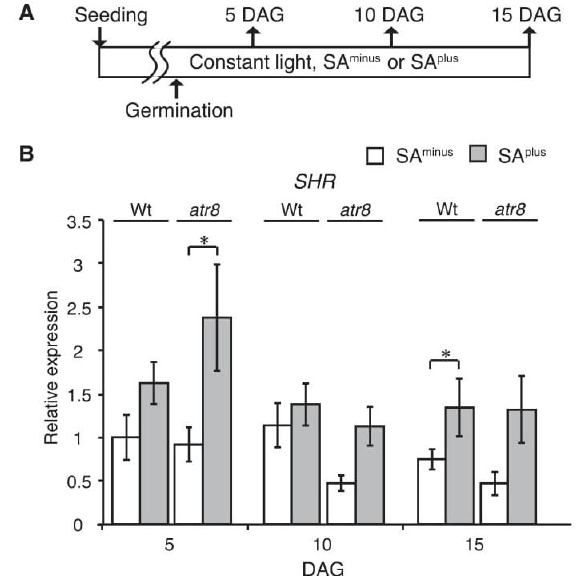
Figure 3. Accumulation levels of SHR mRNAs in Wt and atr8 plants soon after germination. ( A ) Timeline of experimental procedure. Up arrows indicate samplings. ( B ) Time course of SHR mRNA accumulations. Arabidopsis seedlings that were grown on vertical 0.24% gellan gum media with (SA plus ) or without (SA minus ) 20 µM salicylic acid, and total RNAs were extracted at 5, 10, and 15 days after germination (DAG), and subjected to RT-qPCR with ACT2 and ACT8 genes as standards. Bar graphs represent the mean values of three independent assays, and the error bars represent ± SE. Significant differences in RNA accumulation levels between SA minus and SA plus are indicated as * p < 0.05 (Welch’s t -test).